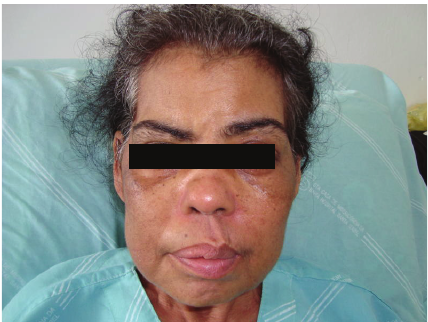
Figure 1: Enlarged right parotid gland and left labial commissural deviation compatible with right peripheral facial nerve